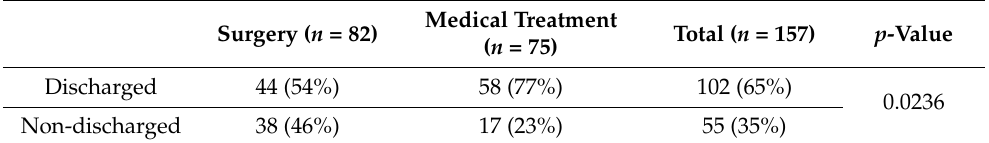
Table 6. Percentage of horses that received a surgical (Surgery) and medical treatment (Medical Treatment) compared with the outcome (Discharged vs. Non-discharged). Statistical significance is set for p < 0.05. Surgery ( n = 82)